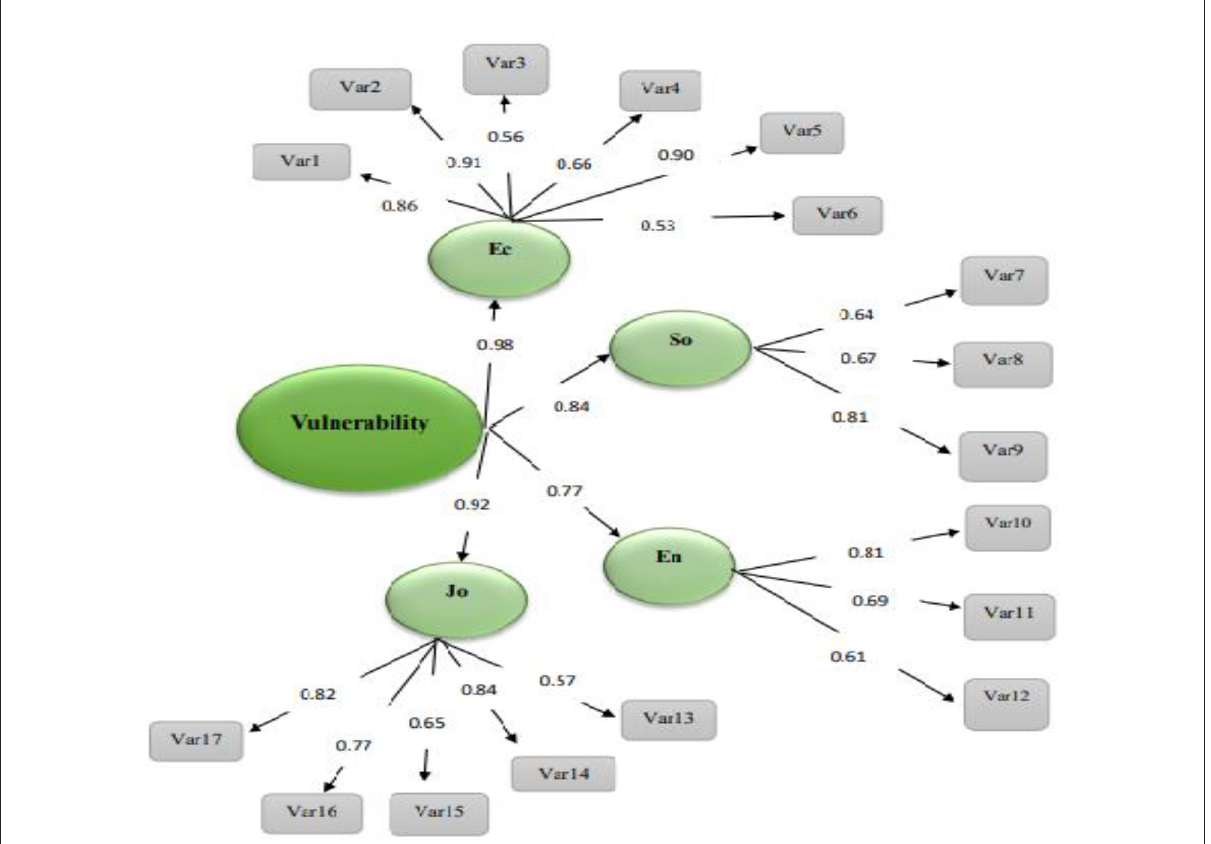
FIGURE1 The standardized coefficients of the paths in the four-factor structure of farmers’ vulnerability to COVID-19.